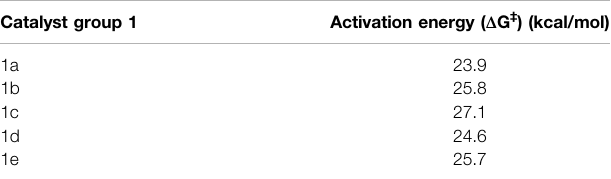
TABLE 1 | Catalytic performance of Group 1 catalyst, 1a – 1e